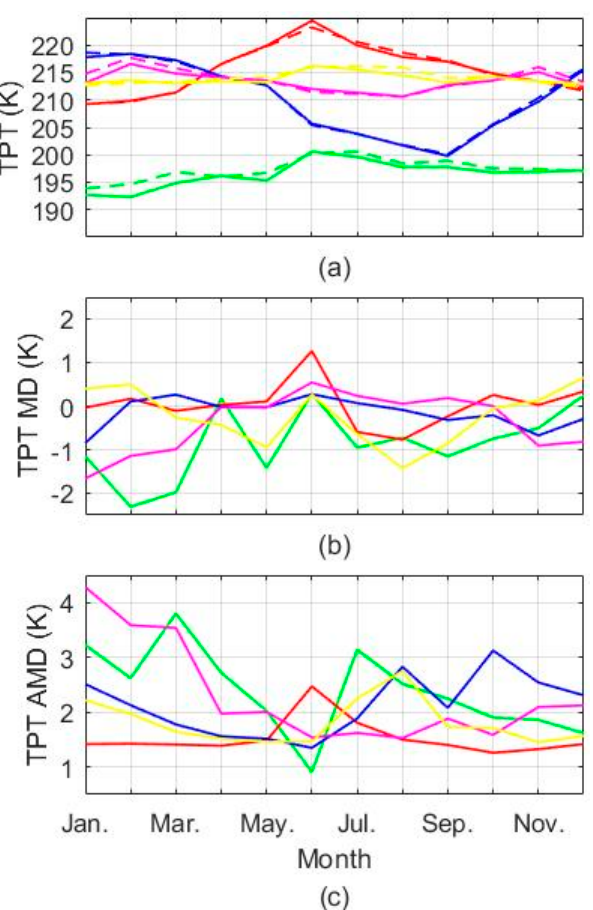
Figure 6. Annual cycle mean tropopause temperature (TPT) ( a ), TPT mean deviation ( b ) and TPT absolute deviation ( c ), which is similar to Figure 5.